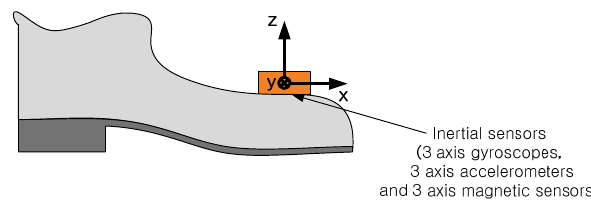
Figure 1. Inertial sensors for the pedestrian navigation system.